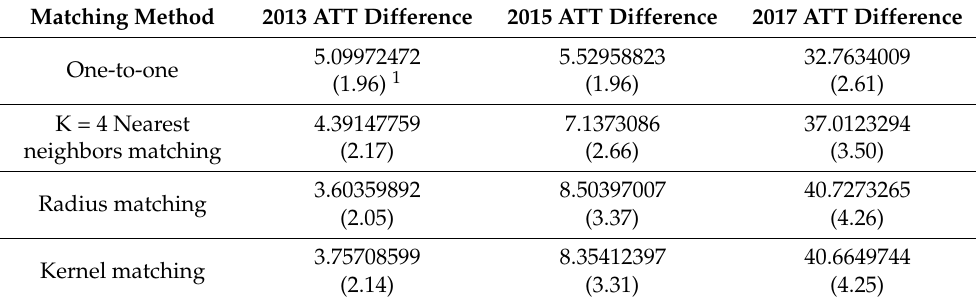
Table 6. Propensity score matching (PSM) method balance test.